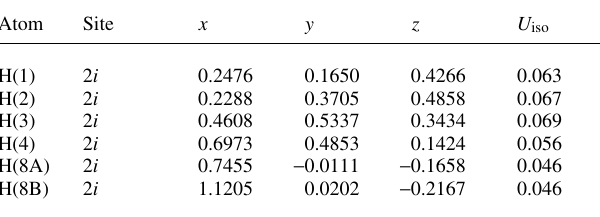
Table 2. Atomic coordinates and displacement parameters (in Å 2 )